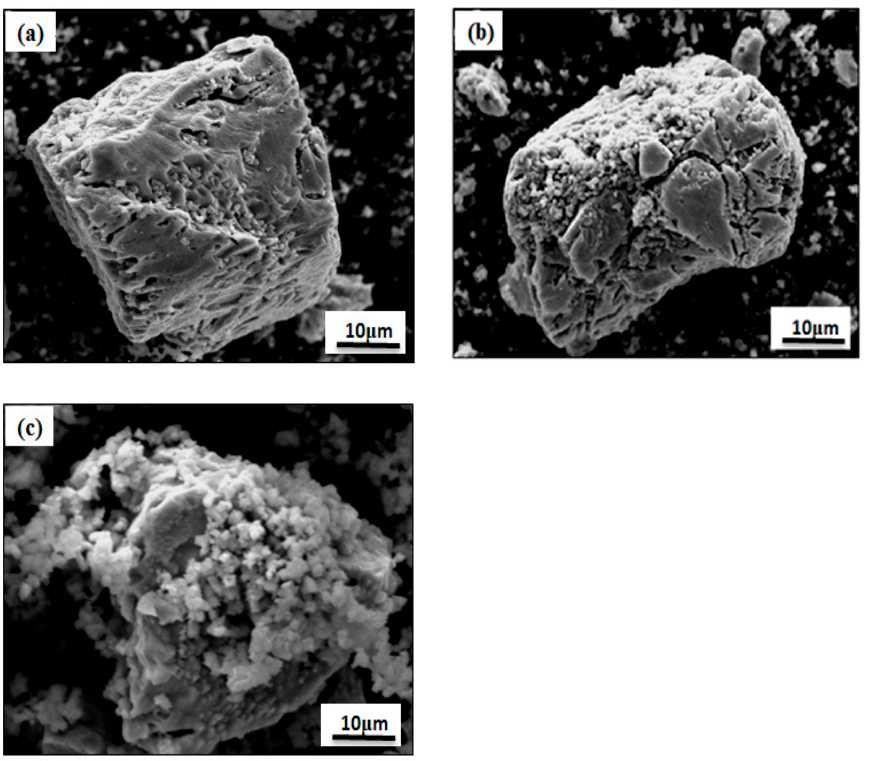
Figure 7. The morphologies of leaching residue after ( a ) 10 days, ( b ) 20 days, and ( c ) 30 days in the bacteria–mineral contact leaching system (SE).